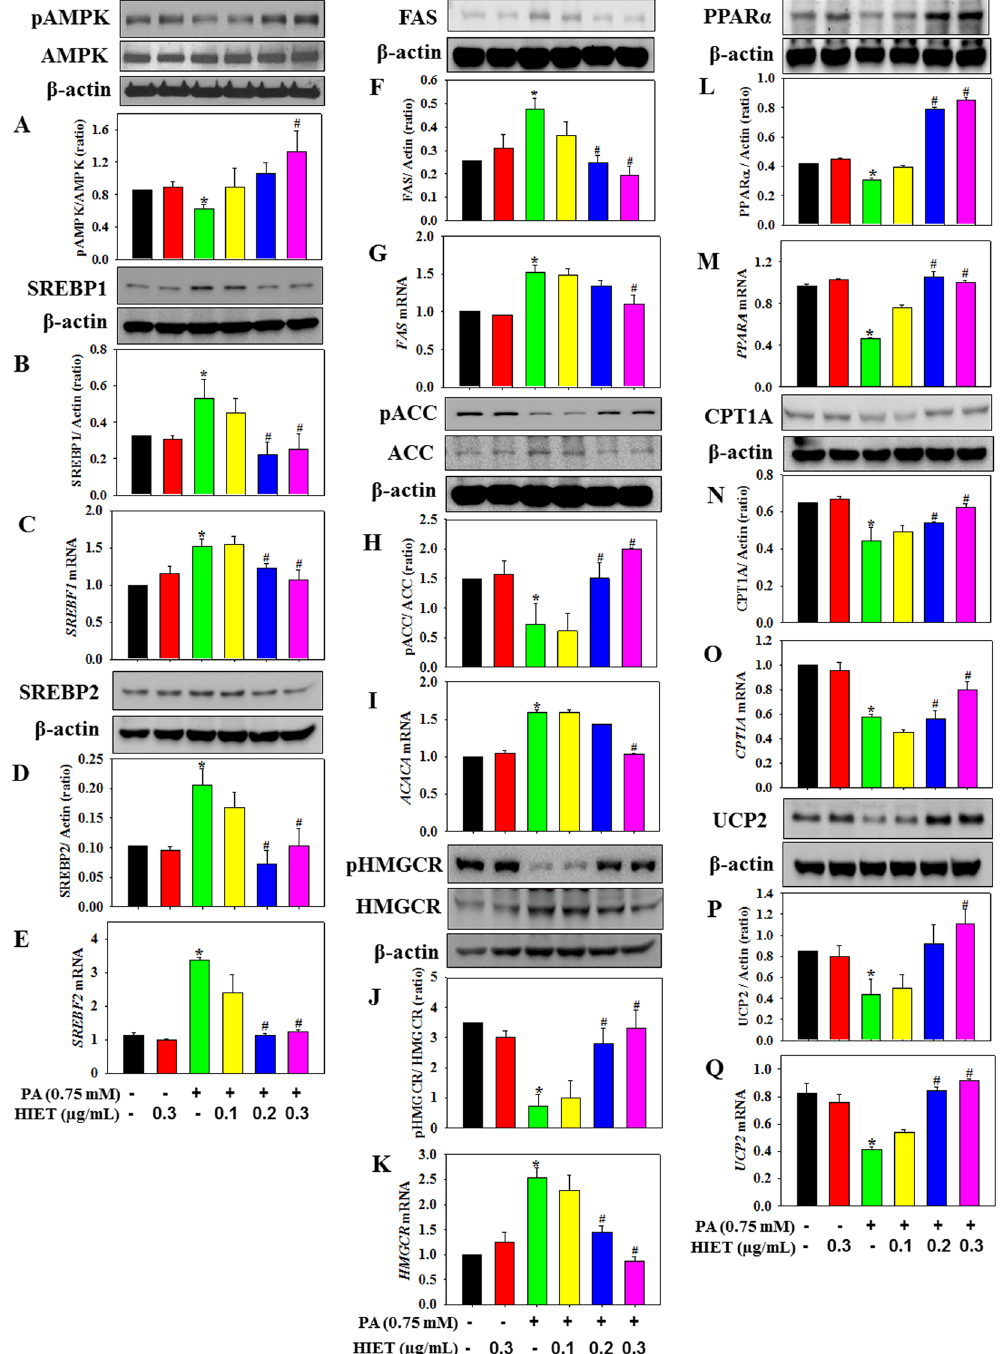
Figure 2. Effect of the hexane-isopropanolic extract (HIET) of Tungrymbai on the protein and mRNA expressions of different signaling molecules involved in lipid metabolism in palmitate (PA)-treated hepatocytes. ( A ) Phospho AMPK/AMPK protein expression; ( B ) SREBP1 protein expression; ( C ) SREBF1 mRNA; ( D) SREBP2 protein expression; ( E ) SREBF2 mRNA; ( F ) FAS protein expression; ( G ) FAS mRNA; ( H ) phospho ACC/ACC protein expression; ( I ) ACACA mRNA; ( J ) phospho HMGCR/HMGCR protein expression; ( K ) HMGCR mRNA; ( L ) PPAR α protein expression; ( M ) PPARA mRNA; ( N ) CPT1A protein expression; ( O ) CPT1A mRNA; ( P ) UCP2 protein expression; and ( Q ) UCP2 mRNA. The blots are representatives of three independent experiments. Full-length blots are presented in Supplementary Figure 2. Cells were pre-treated with HIET (0.1, 0.2, or 0.3 µ g/mL) for 2 h followed by PA (0.75 mM) exposure for the next 20 h. Data are expressed as mean ± SE. “ * ” Denotes the significant difference from untreated ( * p < 0.05) and “#” denotes the significant difference from PA-treated groups ( # p <